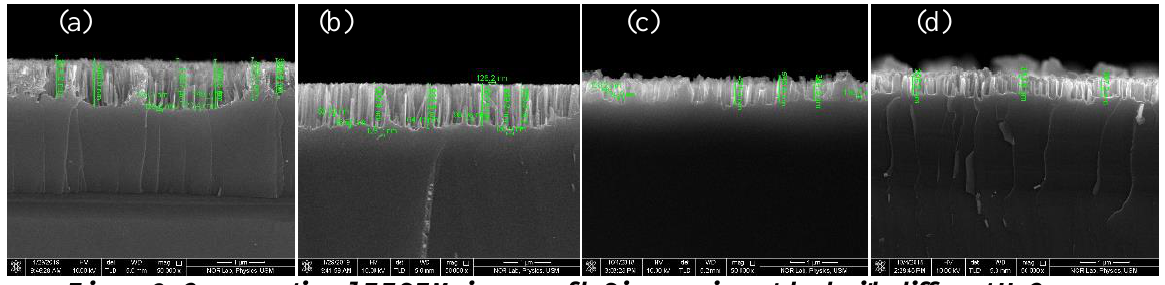
Figure 2: Cross-sectional FESEM images of b-Si nanowires etched with different H concentrations; (a) W: 0.62 M (b) X: 1.85 (c) Y: 2.47 M (d) Z: 3.7 M. The scale bar is with